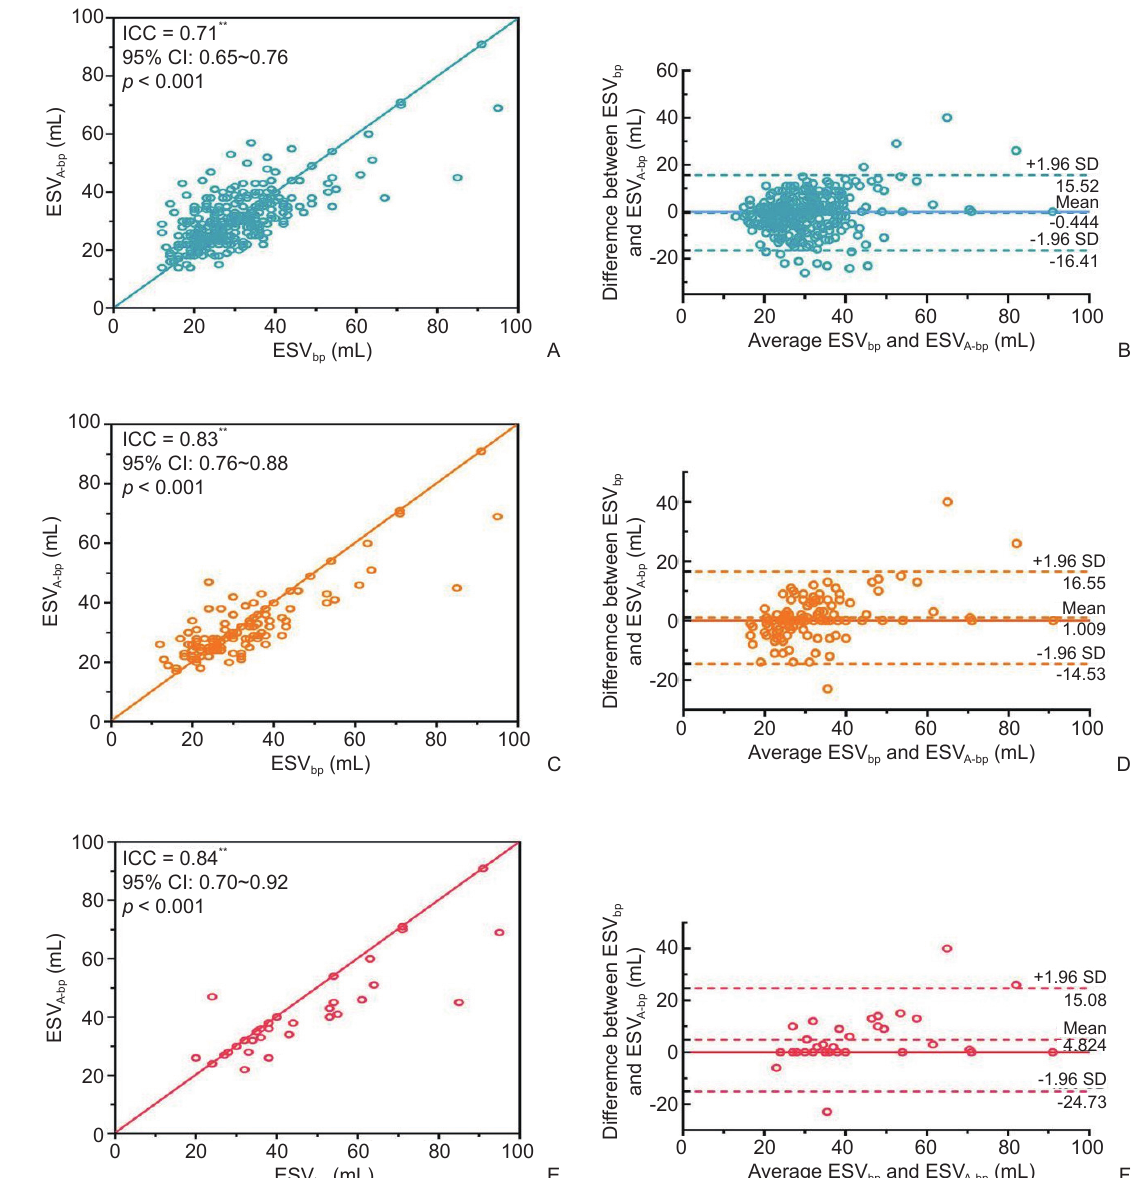
Figure 3 Correlations and Bland–Altman analysis of ESV between different methods. (left) Correlation plots and (right) Bland–Altman plots for manual ESV vs. automated ESV in the common group (A and B), CHD group (C and D), WMA group (E and F). CHD, cardiac heart disease; WMA, wall motion abnormalities; ICC, intraclass correlation coefficients; CI, confidence interval; 95% LoA, 95% limits of agreement; ESV, end-systolic volume; ESV bp was parameter by manual method; ESV A-bp was parameter by automated